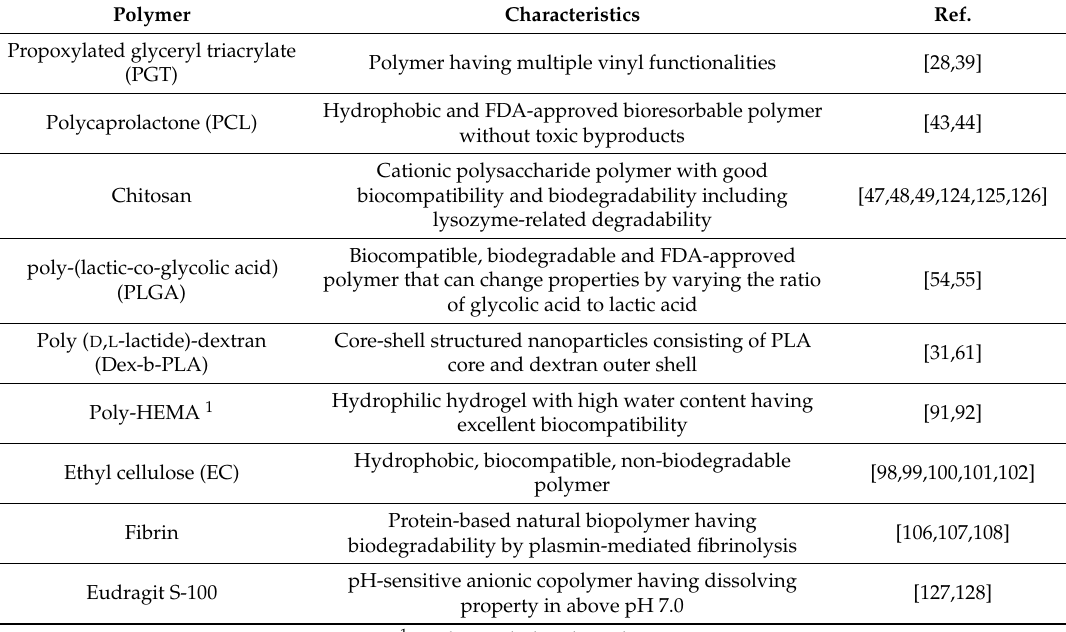
Figure 1. Schematic of drug release onto the ocular surface from drug-eluting therapeutic contact lens. Typical polymeric vehicles for therapeutic contact lenses include drug-loaded polymeric nanoparticles and drug-loaded polymeric implants inside contact lenses. Table 1. Characteristics of various polymers as vehicles for therapeutic contact lenses. Polymer